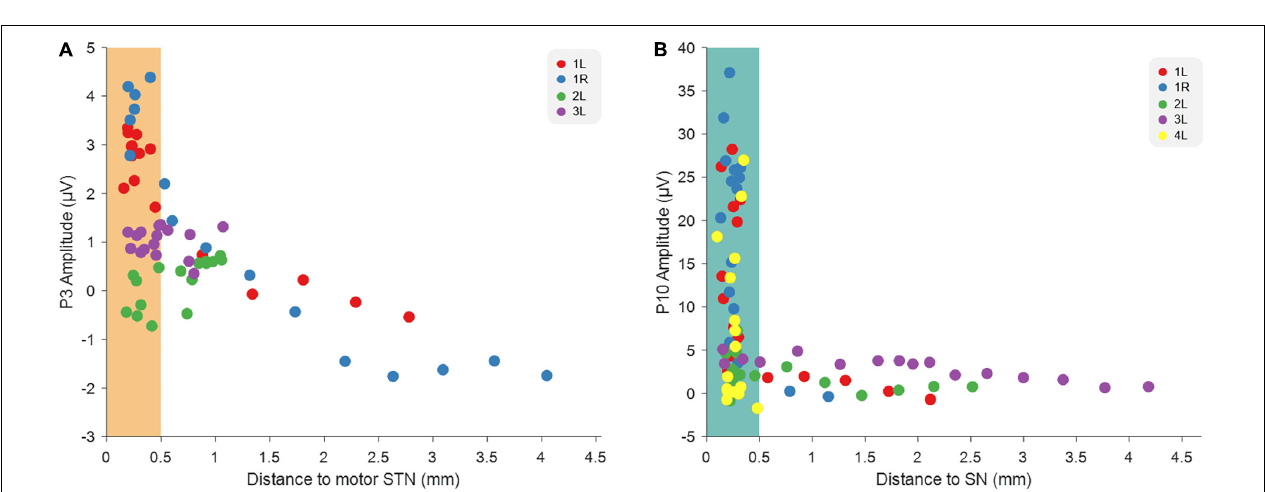
FIGURE 4 | Relationship between EP amplitudes and the distance to image-derived anatomical structures. (A) The relationship between the distance of each MICC-controlled electric field depth to STN and the P3 amplitude recorded on that MICC-controlled depth in four hemispheres ( n = 64). (B) The relationship between the distance of each MICC-controlled electric field depth to SN and the P10 amplitude recorded on that MICC-controlled depth in five hemispheres ( n = 80). The colors indicate the sixteen MICC-controlled depths of the same hemisphere. When the distance was smaller than 0.5 mm, the electric field center was determined as “within” either dorsolateral STN (orange rectangle) or SN (blue rectangle).